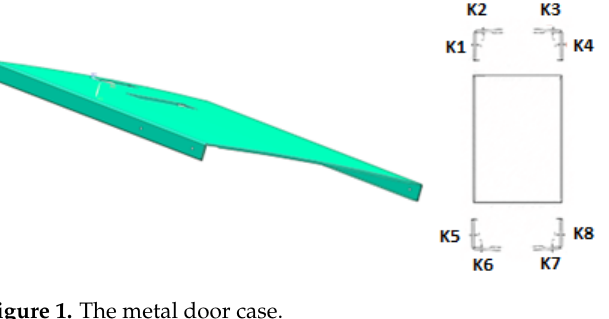
Figure 1. The metal door case.